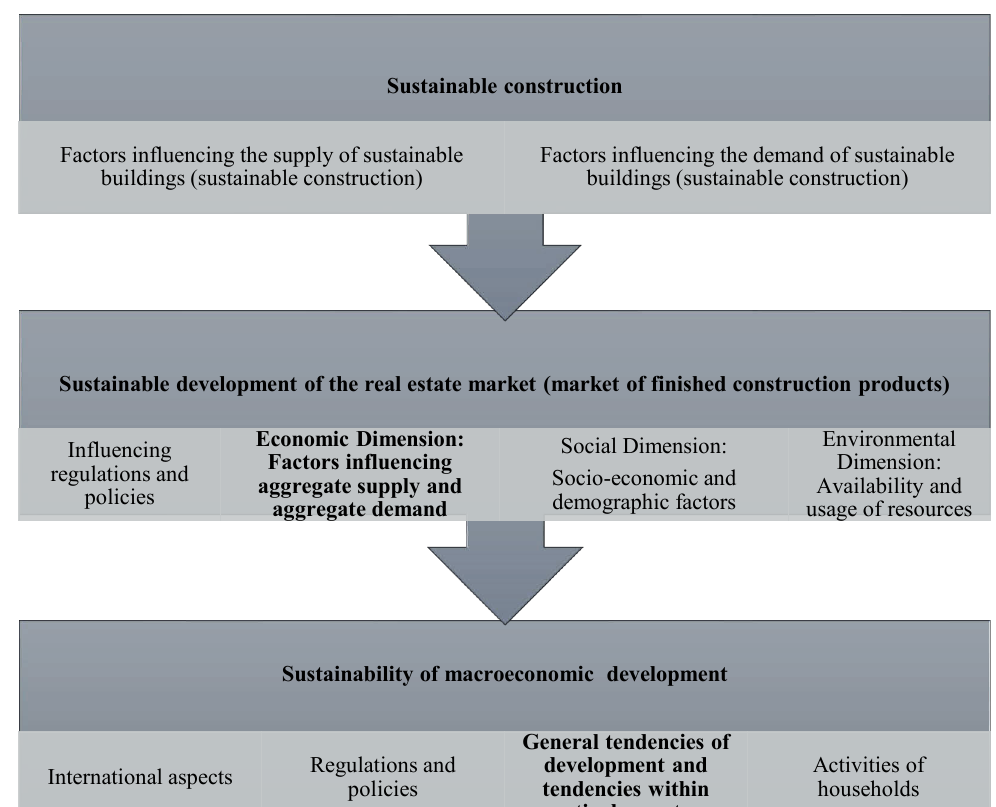
Fig. 3. The model of interconnection of sustainable development of the real estate market, construction and macroeconomic development (developed by the authors, based on (Kauskale,